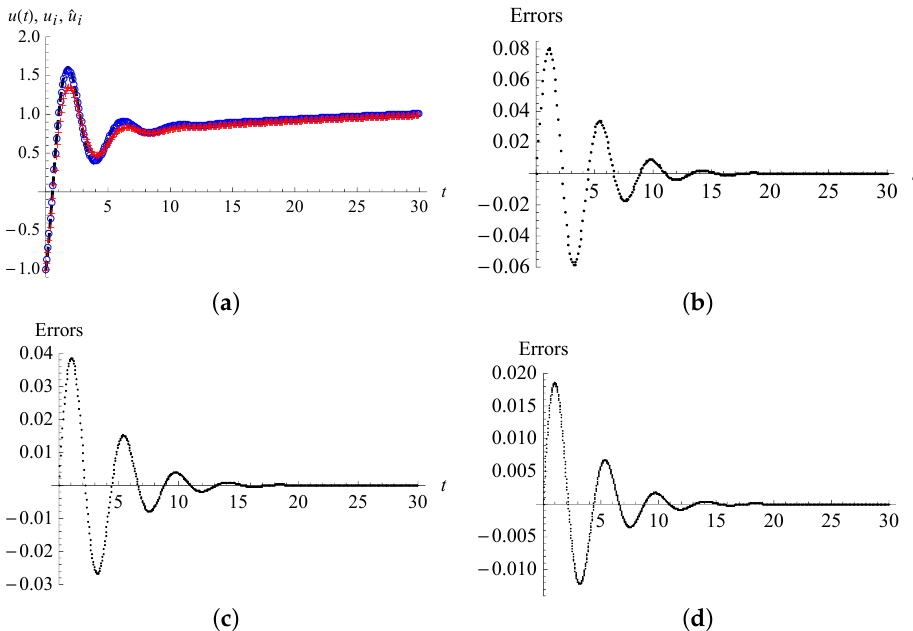
Figure 1. The exact solution u ( t ) , numerical solutions u i and ˆ u i , and the errors of u i in Example 1. ( a ) The exact solution u ( t ) (dash line), the quadratic spline numerical solutions u i (circles) and the L 1– L 2 numerical solutions ˆ u i (crosses) with h = 0.1; ( b ) the errors of u i ( h = 0.1); ( c ) the errors of u i